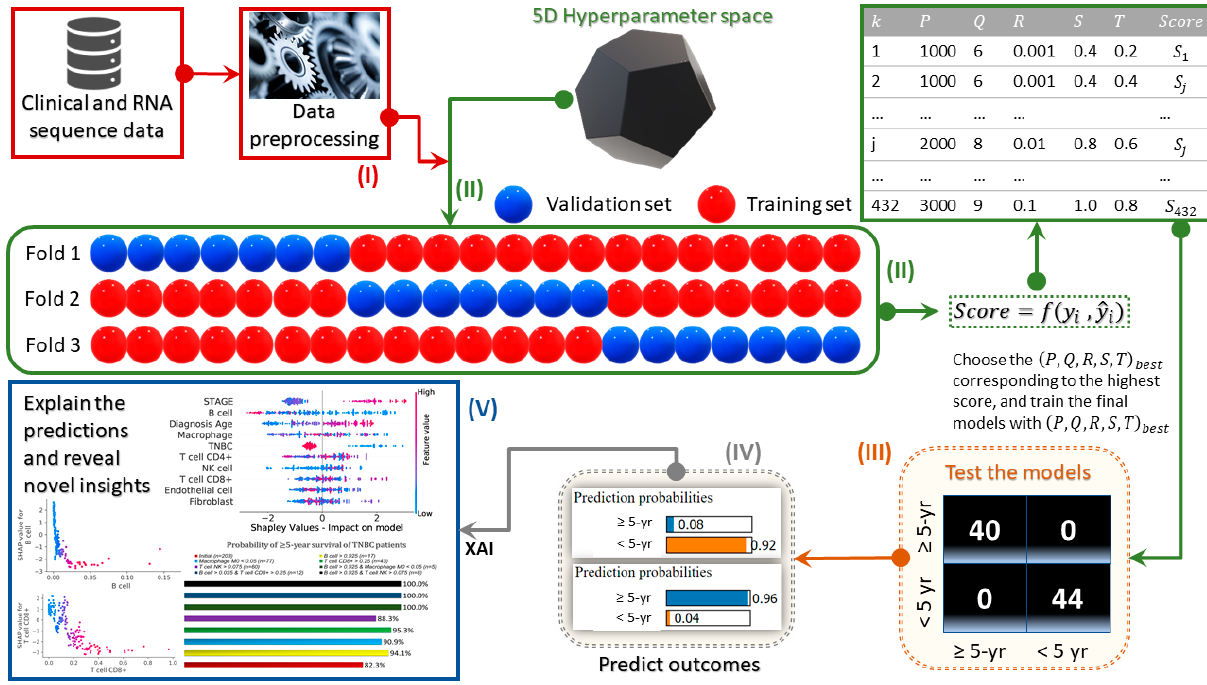
Figure 1. Schematic representation of the modeling pipeline: (I) data preprocessing steps, which include encoding categorical features as integer arrays and data oversampling to convert from an imbalanced to a balanced dataset (i.e., the numbers of surviving and deceased patients were made nearly equal) to avoid bias (i.e., preventing the model from ignoring minority classes); (II) hyperparameter optimization via a 3 ‐ fold cross ‐ validation to find the best subset of hyperparameters ( 𝑃 : number of estimators, 𝑄 : maximum depth of each estimator, 𝑅 : learning rate, 𝑆 : subsample ratio, 𝑇 : column sample ratio for each estimator) that improves the models’ ROC–AUC score { 𝑓(cid:4666)𝑦 (cid:3036) , 𝑦(cid:3548) (cid:3036) )} signifying the area under the receiver operating characteristic curve during the (432 × 3) iterations over the hyperparameter space (i.e., to enhance the predictive accuracy of the XAI models); (III) testing of the predictive accuracy of the final AI models after being trained with the best subset of hyperparameters; (IV) prediction of the probability of the clinical outcomes with AI models; (V) explanation of the predicted outcomes with a game theory ‐ based XAI model to enhance the interpretability and explainability of the model predictions, identification of critical inflection (turning) points, above or below which the ≥ 5 ‐ year survival rates increase, and assessing the conditional probability of ≥ 5 ‐ year survival rates from the range of TME factors determined by the inflection points.